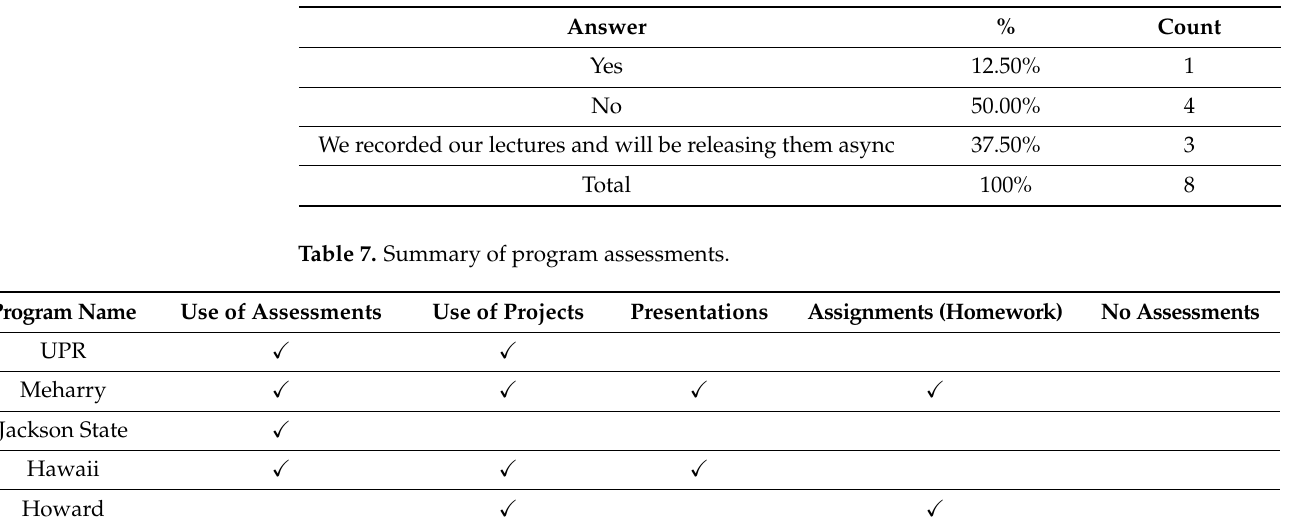
Table 6. Count of programs offering asynchronous options (q14).